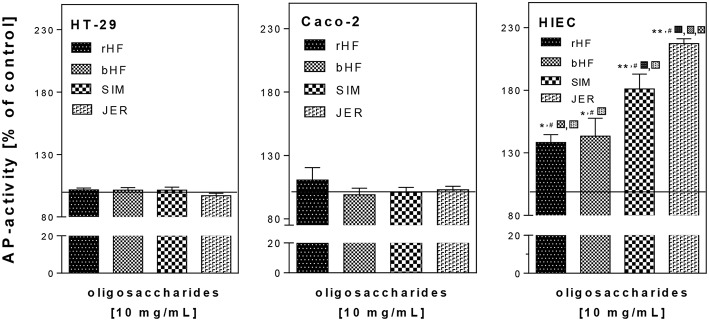
Effect of BMO on the differentiation of intestinal epithelial cells. After incubation with 10 mg/mL BMO, differentiation was determined by measuring alkaline phosphatase (AP) activity after 72 h. Results were expressed as % of control (untreated, solid line); each value represents the mean with their standard error (n = 3). Significant differences compared to the untreated control are indicated with *P < 0.05 and **P < 0.01; # indicates significant interbreed variation at 10 mg/mL.